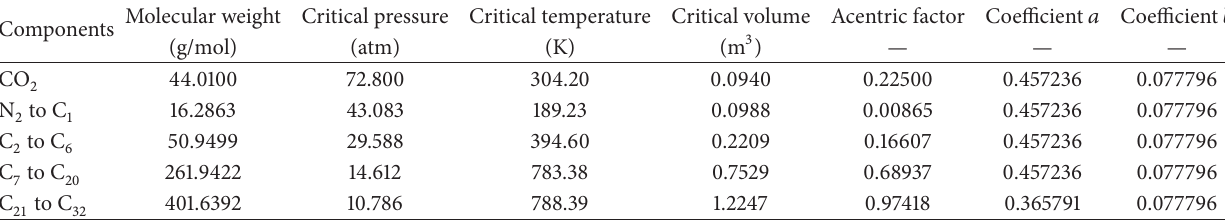
Table 6: Characteristic parameters of formation of nonaqueous fluid